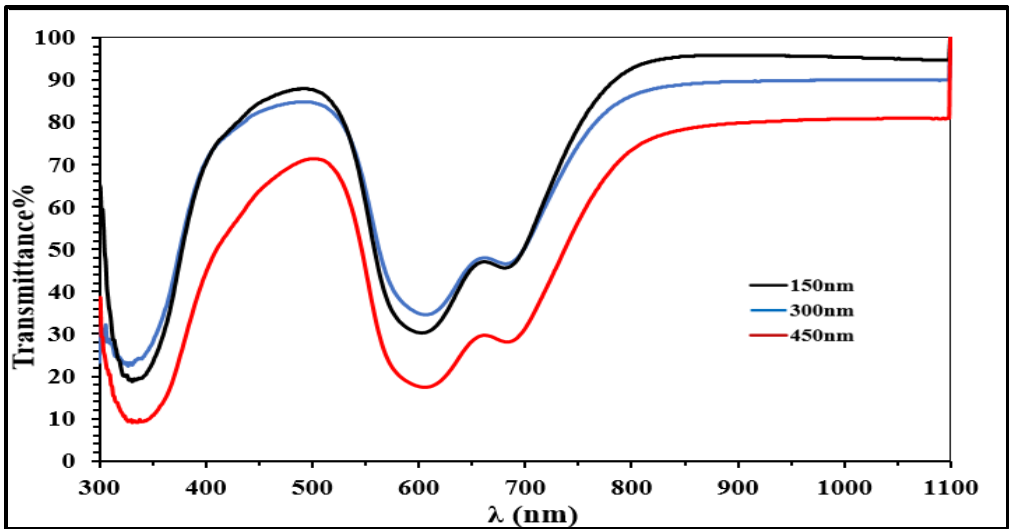
Fig.3: Transmission spectra for CuPc thin films that are prepared through the technique of PLD at different